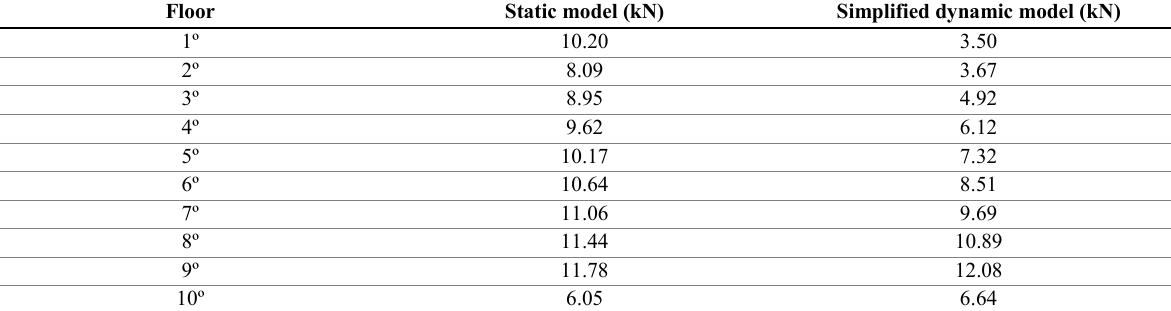
Table 6. Forces caused by the wind.